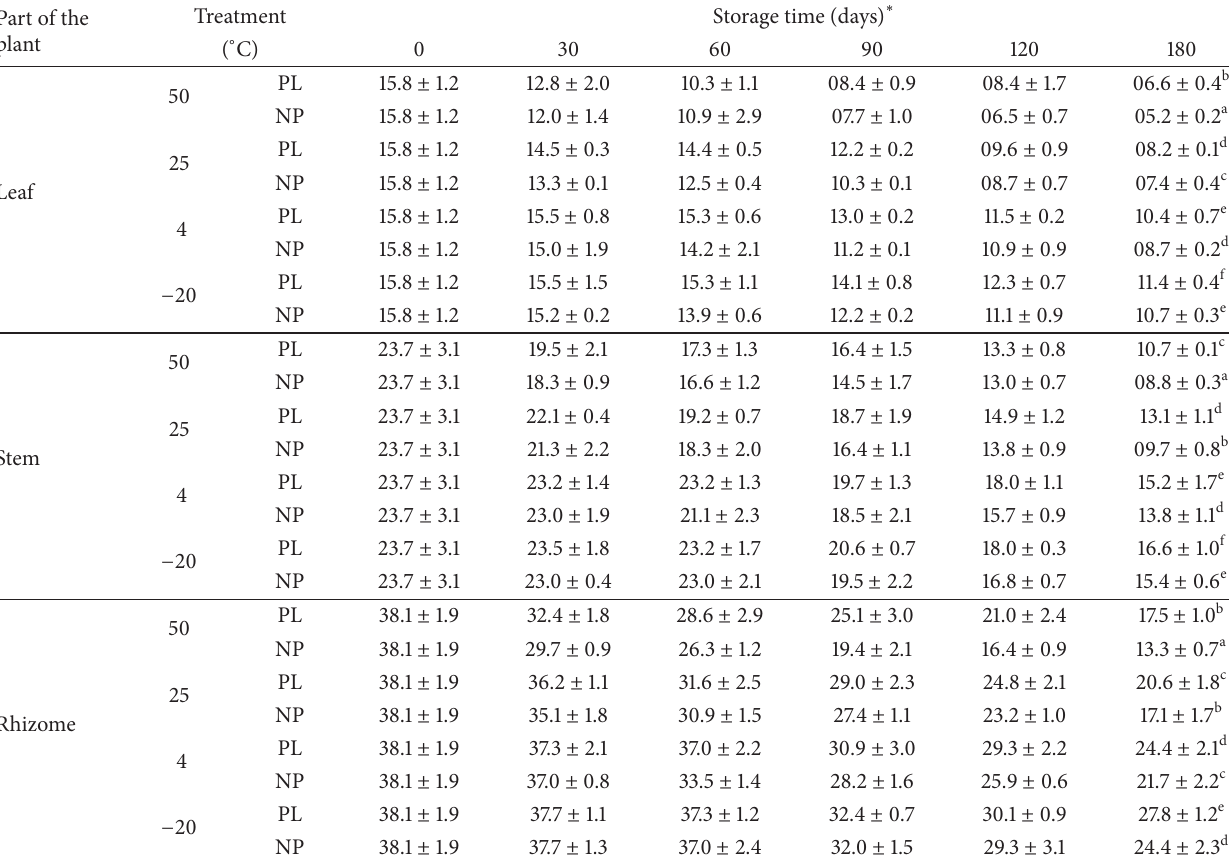
Table 3: Changes in total flavonoids during storage of extracts from Anemopsis californica . Treatment Storage time (days ) Part of the plant